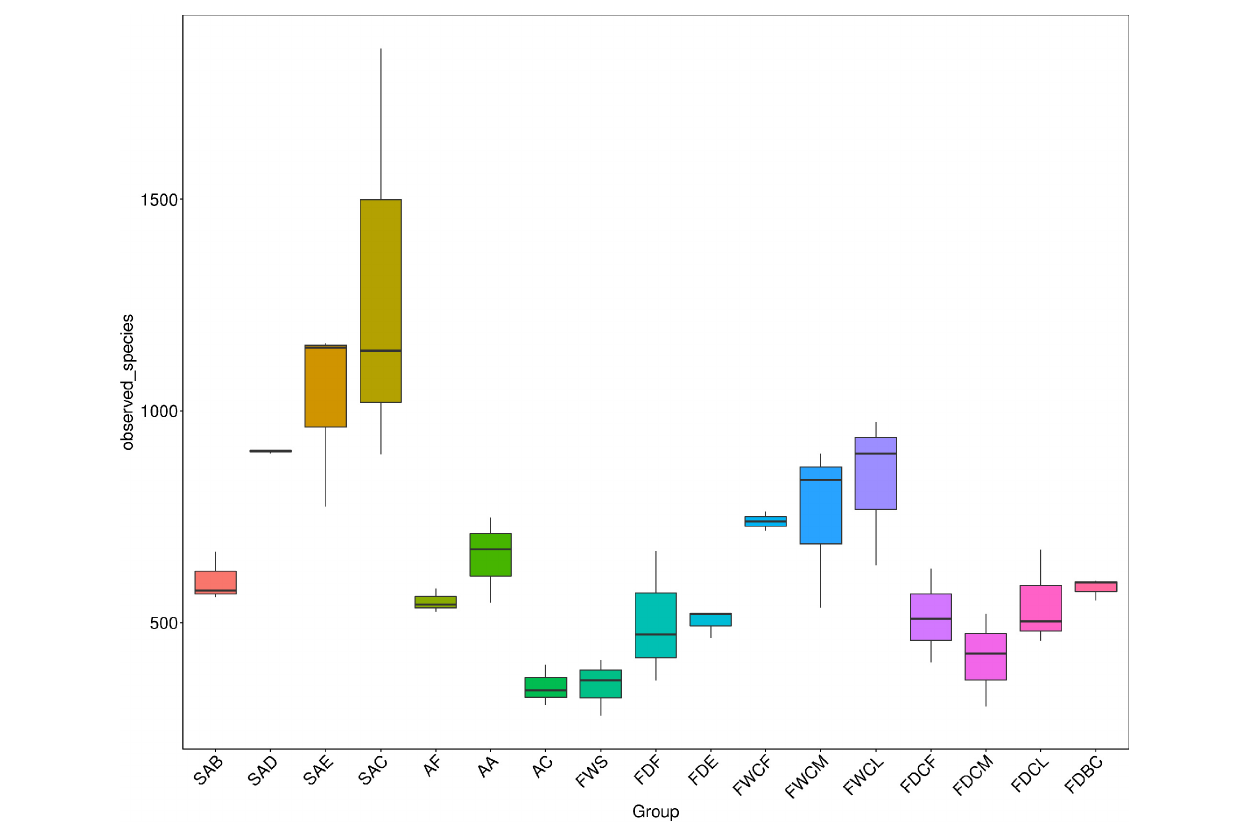
FIGURE 2 | The analysis of the differences in the α diversity index between the follicles and potential contaminant samples during slaughter. SAB, SAD, SAE, and SAC group indicate, respectively, samples of skin with follicles after bleeding, defeathering, evisceration, and chilling processes. AF, AA, and AC group indicate, respectively, the carcass appendage samples of feather, craw, and anal contents. FWS, FWCF, FWCM, and FWCL group indicate, respectively, the water samples from the slaughter facilities: scalding tank and the first, middle, and last chillers. FDF, FDE, FDBC, FDCF, FDCM, and FDCL group indicate, respectively, the surface dirt samples of the slaughter facilities: defeathering; evisceration; the conveyor belt in the cutting area; and walls underwater of the first, middle, and latter